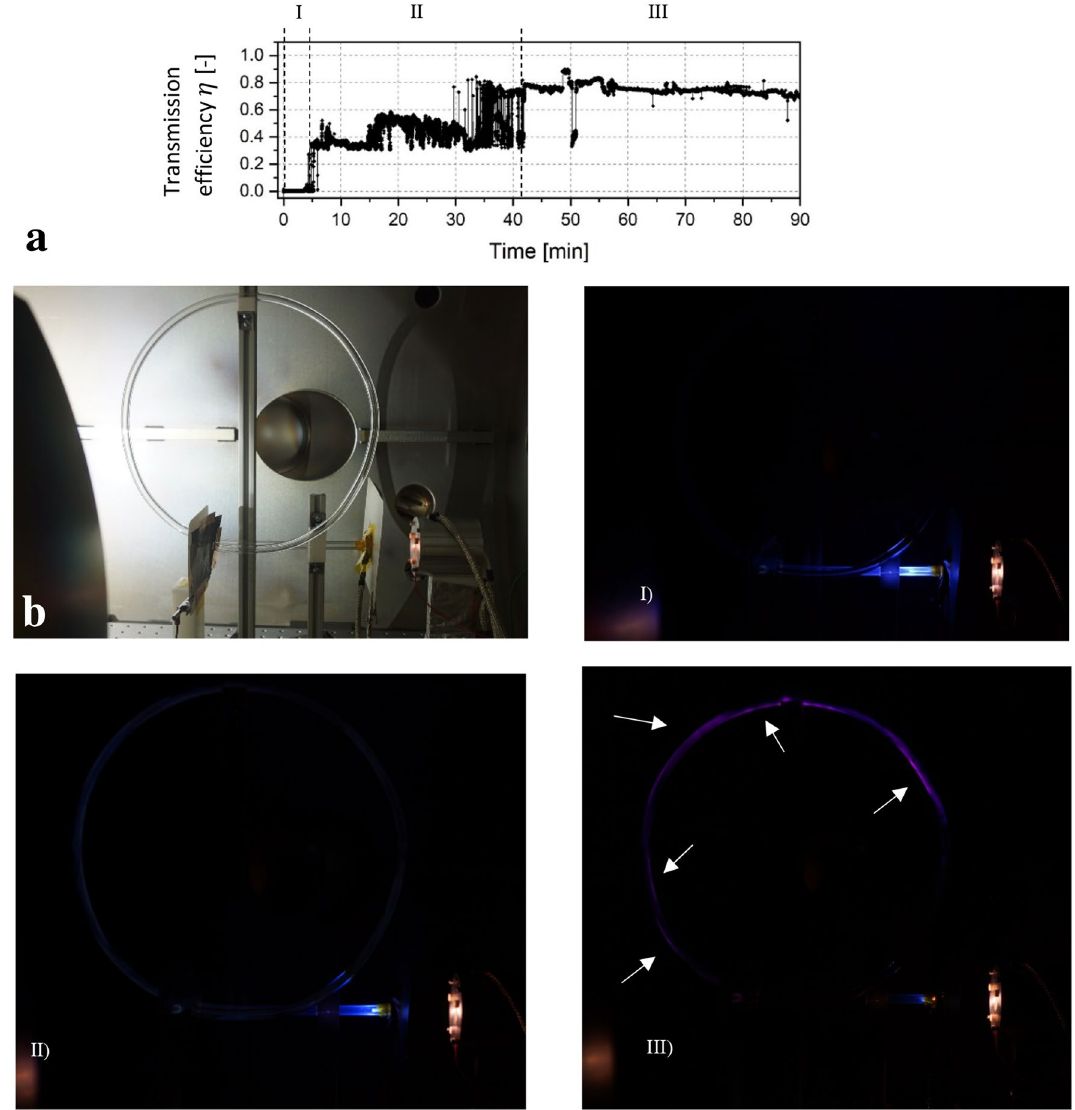
Figure 8. 360° capillary and its glow states: ( a ) Data plot with different guiding stages, ( b ) General setup, (I) Initial glow state before guiding, (II) Intermediate phase with dynamic electron transmission, (III) During Equilibrium. The arrows point on visible glow spots formed inside the